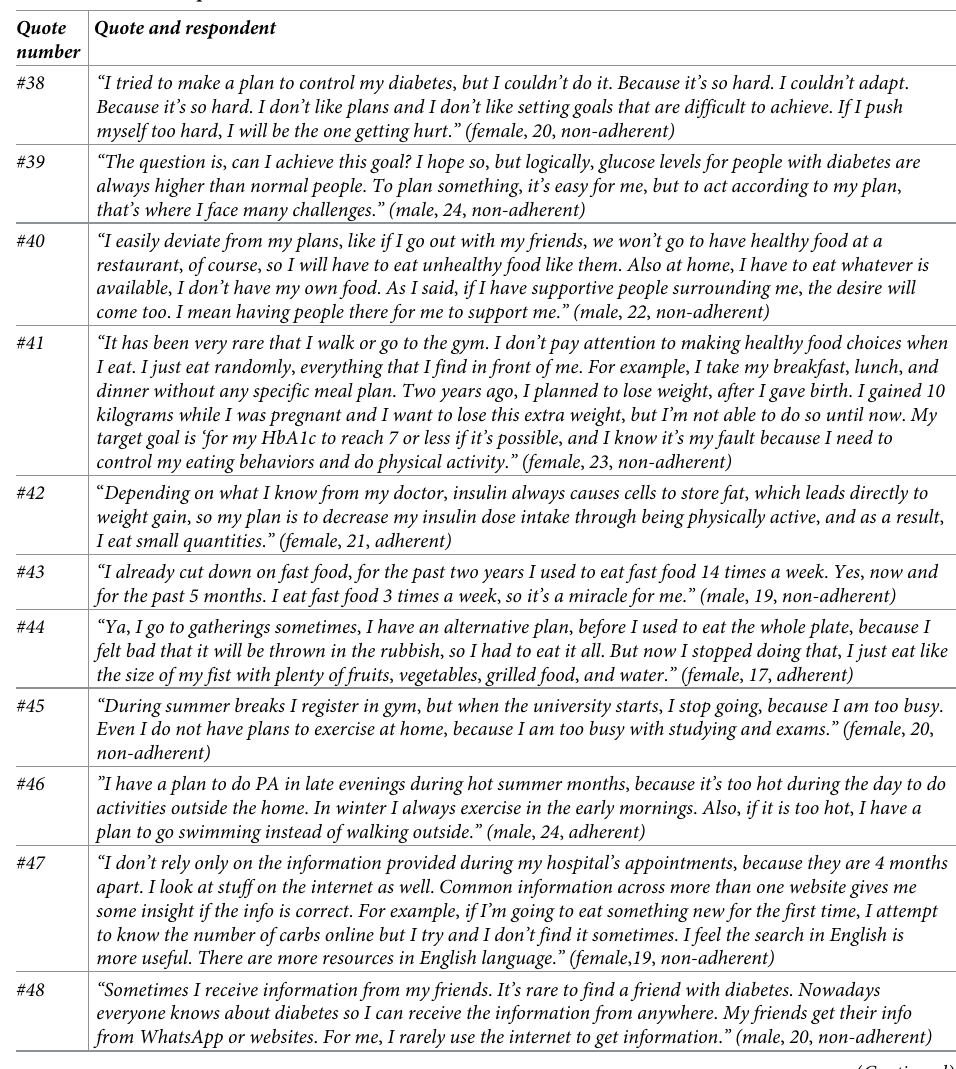
Table 5. Interviewee quotes: Post-motivational and distal information